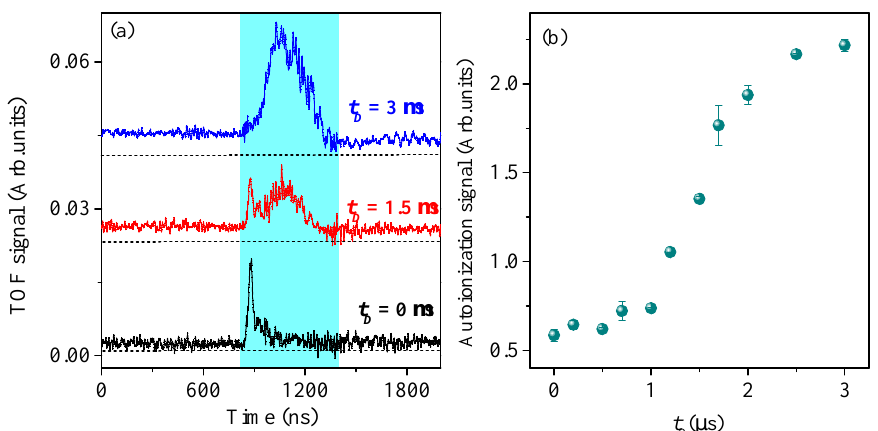
Figure 4. ( a ) Measured TOF spectra of autoionization signals for laser excitation to 37 D 5/2 Rydberg state with the indicated delay time t D and the fixed Rydberg atomic density ρ = 2.96 × 10 9 cm − 3 . The cyan region marks the boxcar gate. The ramped field E ion (cid:46) E thres . The zero point is the beginning of the ramped field. ( b ) Measurements of the autoionization signals of 37 D 5/2 Rydberg state as the function of delay time t D . The data display the average of 100 measurements at the two-photon